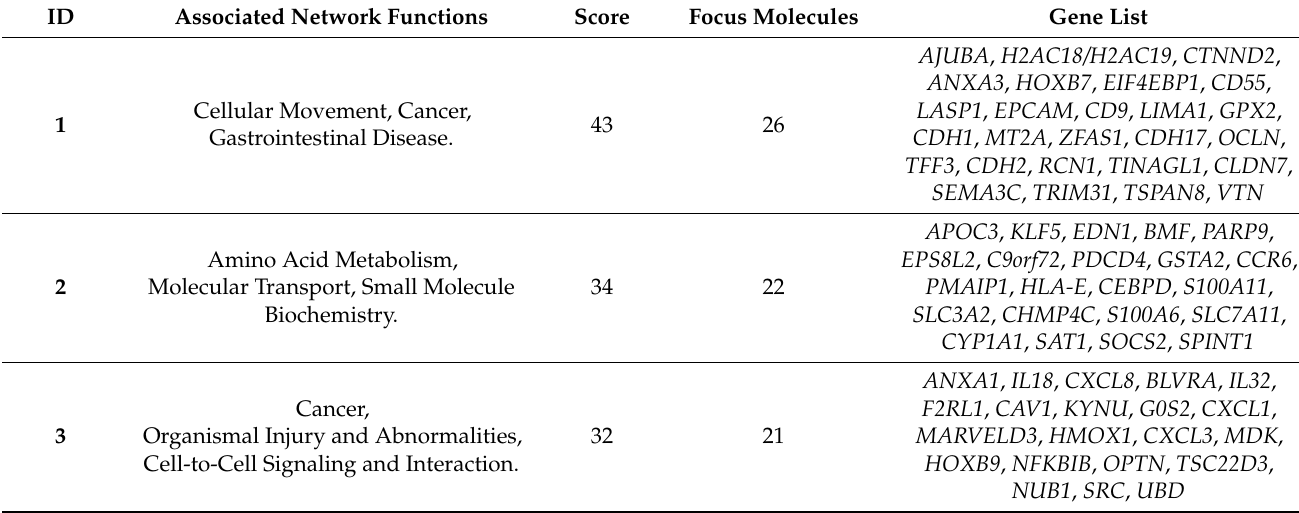
Table 2. Long-term low viral load (L-LVL)-associated network